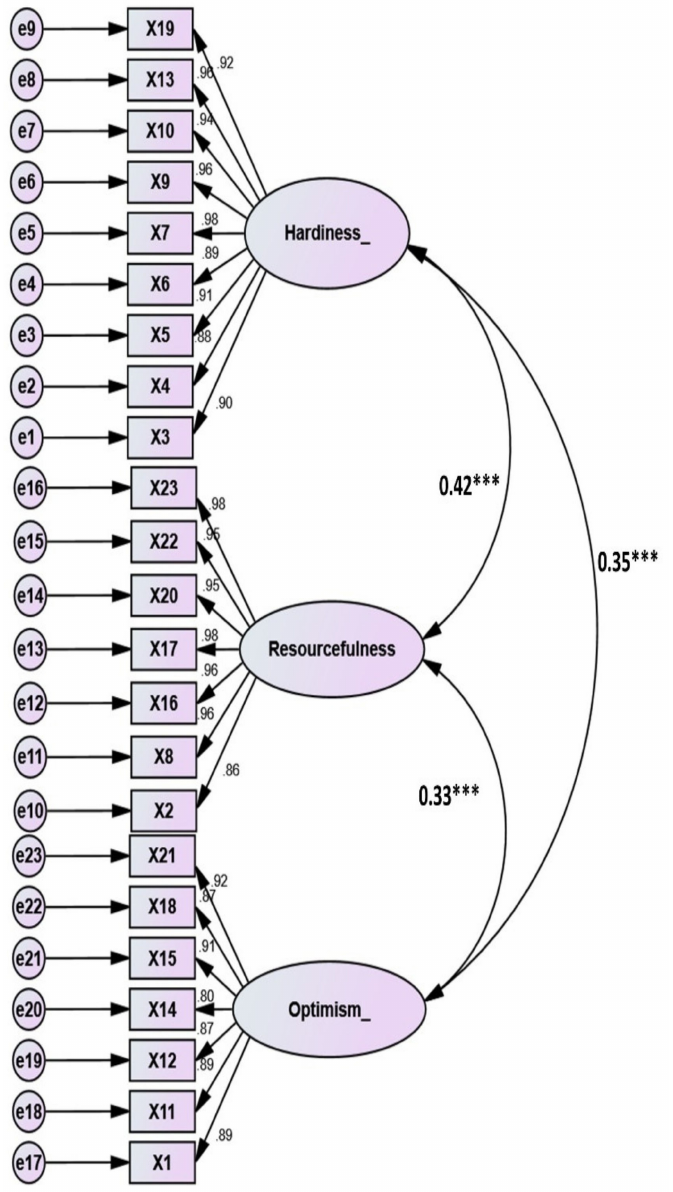
Figure 3. Three-factor measurement and structural model. ***: significant level less than